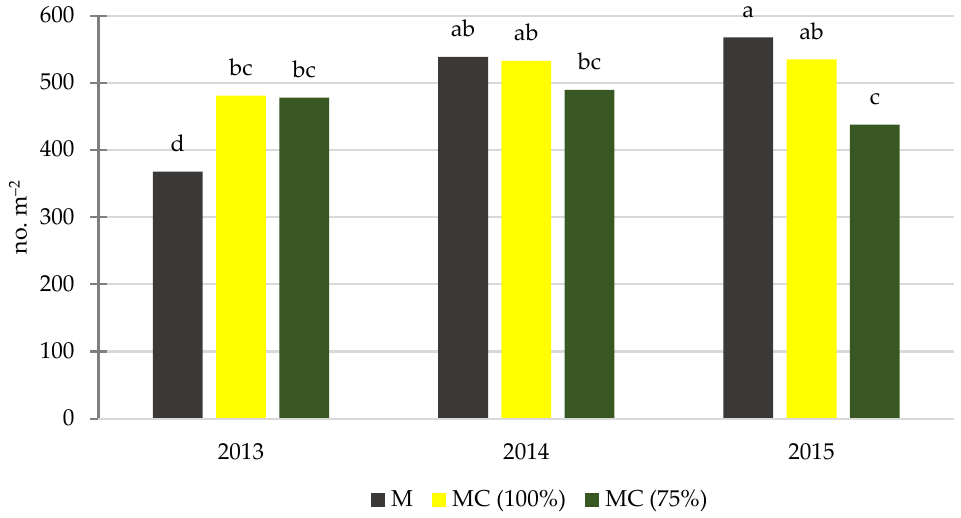
Figure 3. Interaction of the weed control methods and research years in determining number of ears of spelt wheat. M—mechanical; MC (100%)—mechanical and chemical (dose of herbicides 100%); MC (75%)—mechanical and chemical (dose of herbicides 75%). Different letters denote significant differences ( p ≤ 0.05). The same letter represents not significantly different values ( p ≤ 0.05).